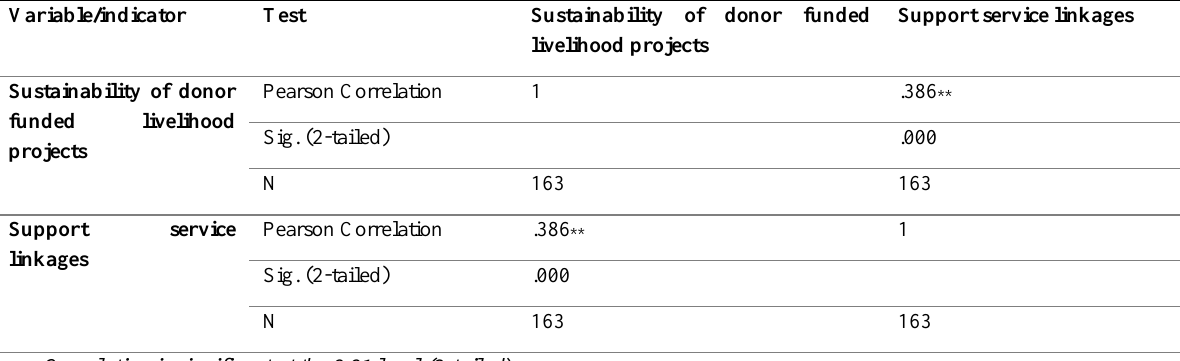
Table 5: Correlation between support service linkages and sustainability of DFLPs